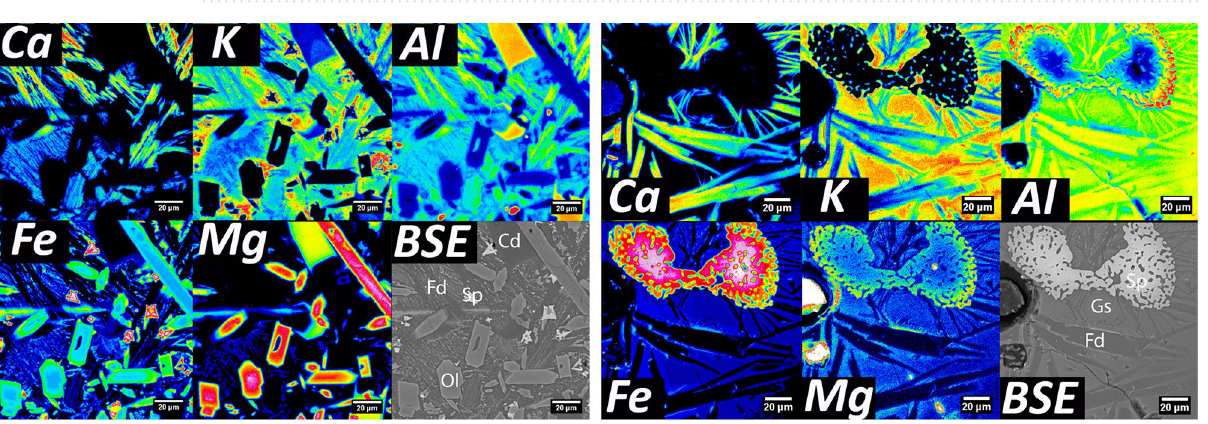
Figure 3. Microchemical imaging of vitrified hillfort samples. EPMA-WDS maps (left) Bro-B exhibiting cordierite (Cd), spinel (Sp), and olivine (Ol); (right) WDS Bro-W exhibiting feldspar (Fd) and relict